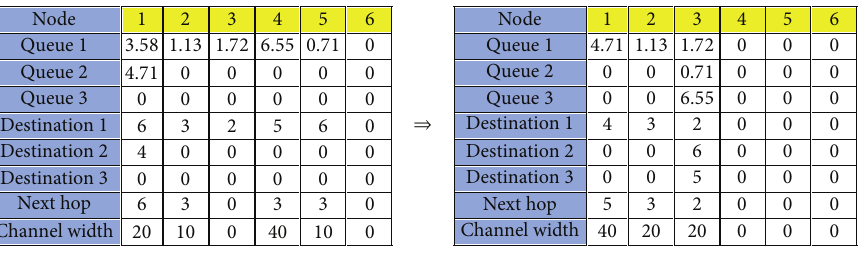
Figure 6: Encoding the configuration for a single time slot.